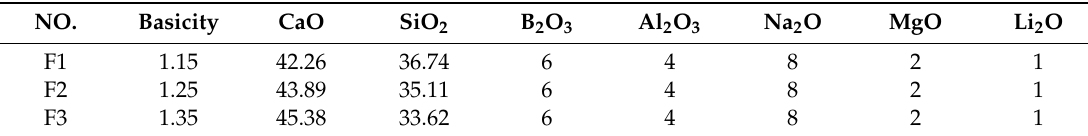
Table 3. Composition content of fluorine-free mold fluxes